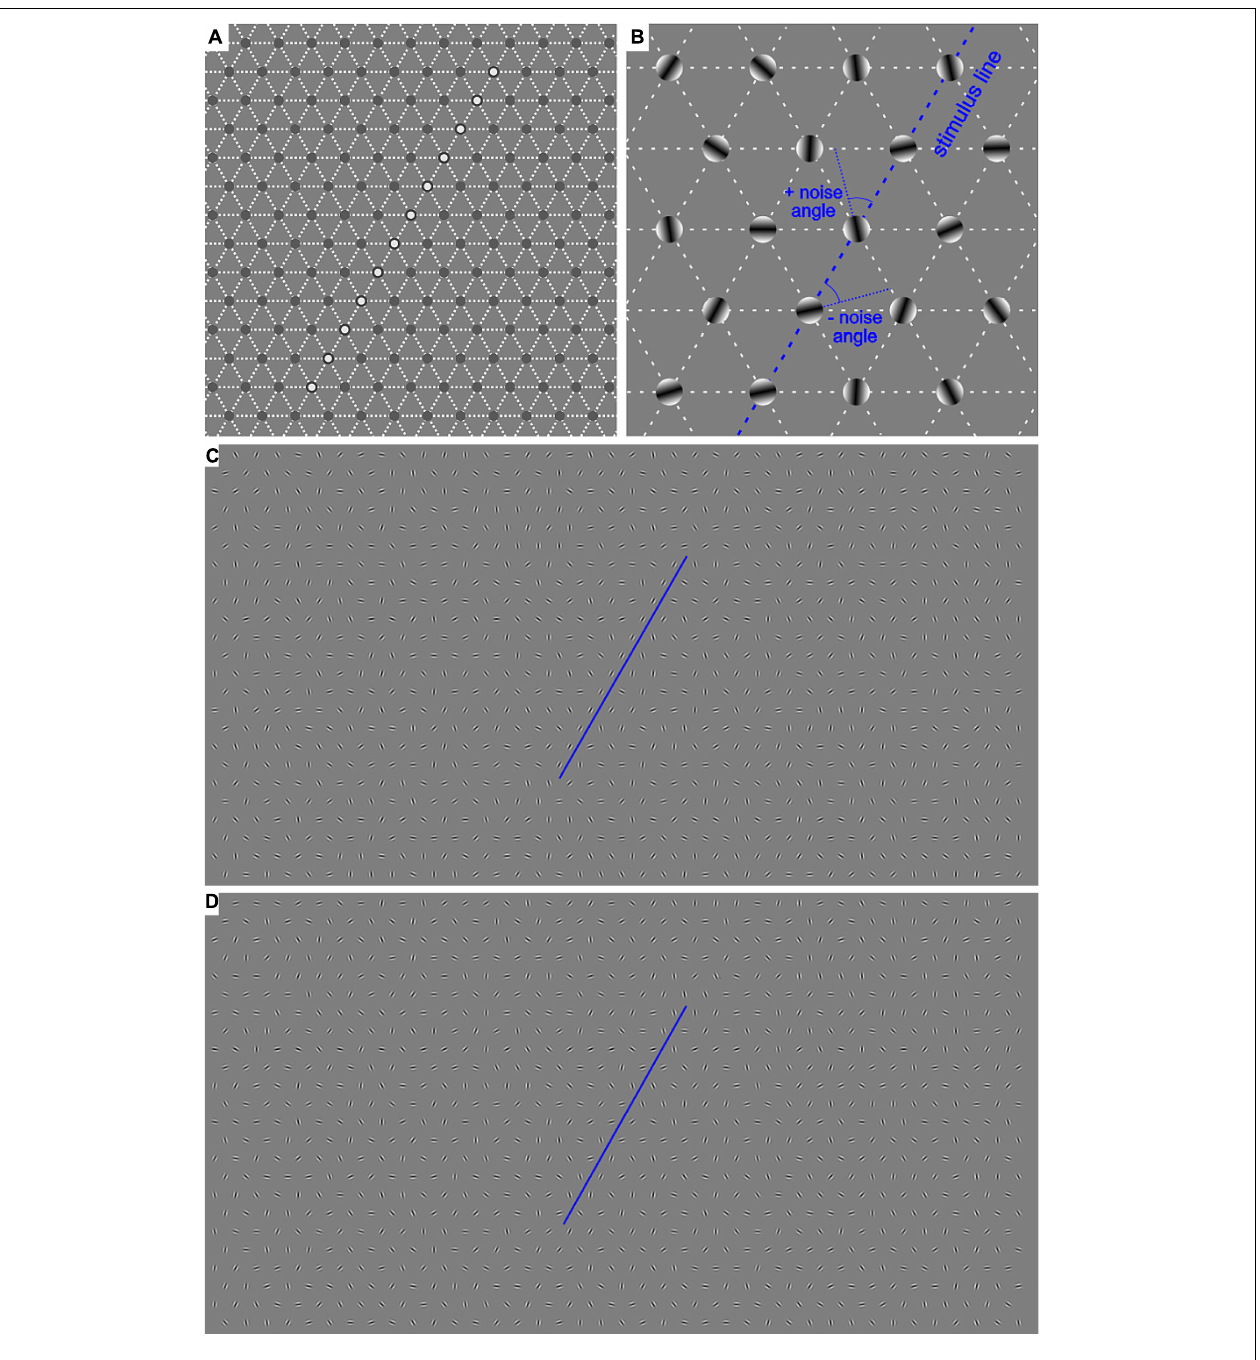
FIGURE 1 | (A) Example of the central area of the invisible hexagonal grid on which the Gabor patches were positioned. The white circles in the most central area denote the positions where the contour appeared in half of the trials. (B) Demonstration of the generation of the external noise added to the contour. (C,D) Examples of the whole screen with a contour in the no-noise condition (0 ◦ , C ) and in 45 ◦ noise condition (D) . The blue lines underline the contour stimulus.